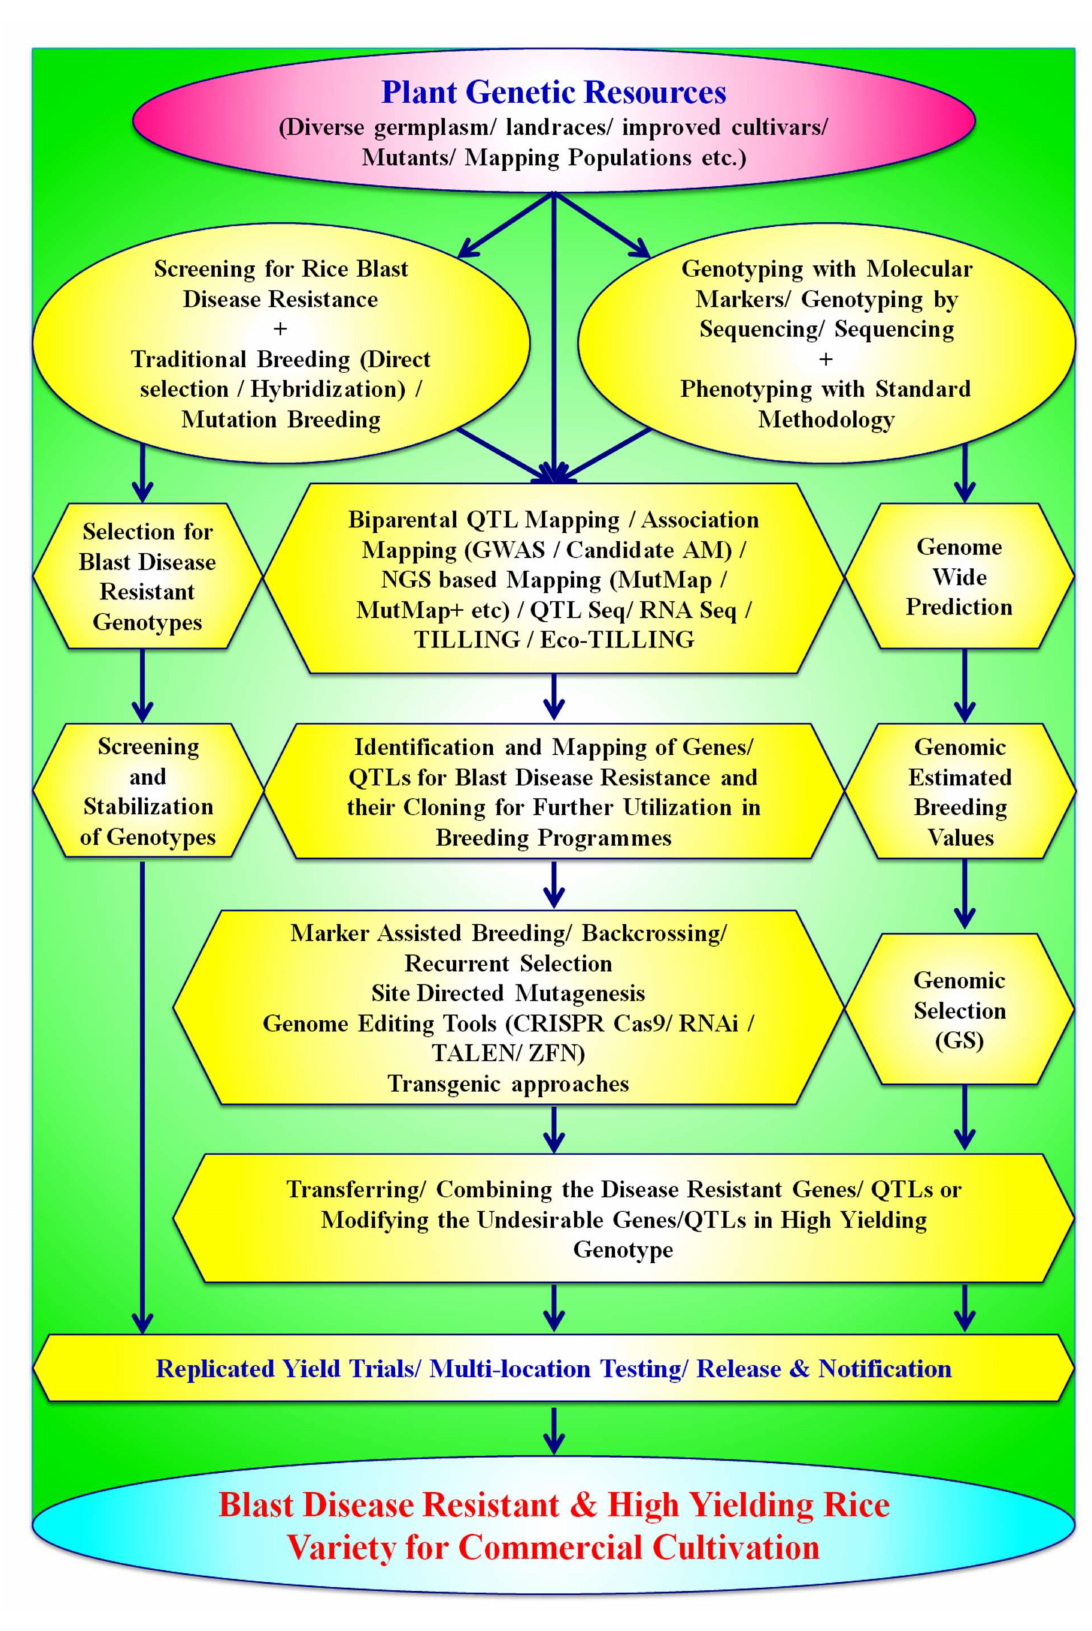
Figure 4. Schematic representation of various breeding biotechnological approaches used for devel- opment of blast-resistant rice